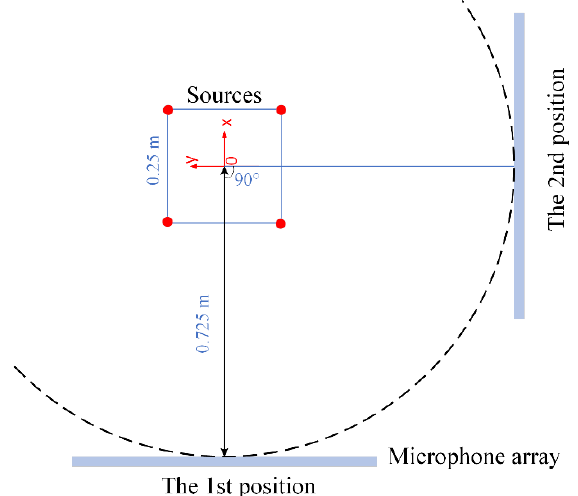
Figure 17. The top view of the moving strategy for the microphone array in the experiment.